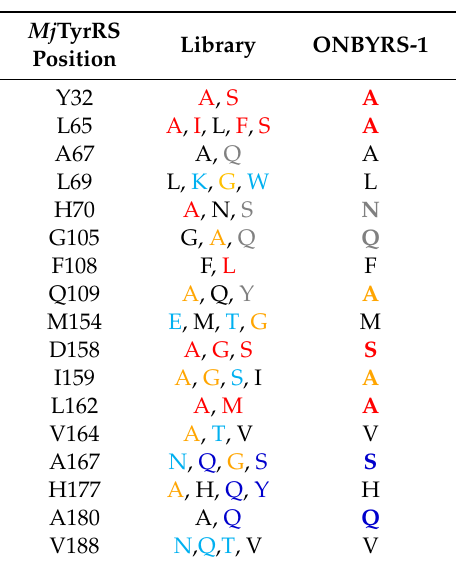
Table 1. aaRS library resulting from curated Rosetta calculations and sequence of the experimentally selected Mj TyrRS variant.